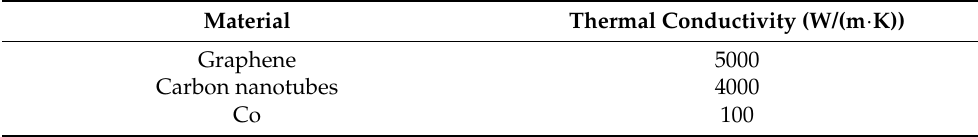
Figure 1. Schematic diagram of RVE model building. They should be listed as: ( a ) RVE finite element model; ( b ) A model of a filler (Carbon nanotubes); ( c ) A model of a filler (Graphene). Table 1. FEM simulation of the thermal conductivity of the materials used.